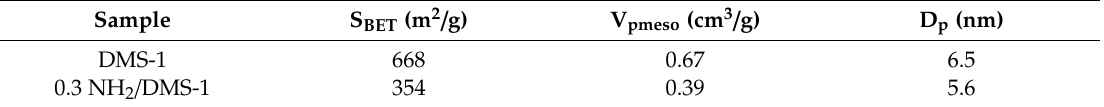
Table 1. Textural properties a of calcined DMS-1 before and after functionalization with NH 2